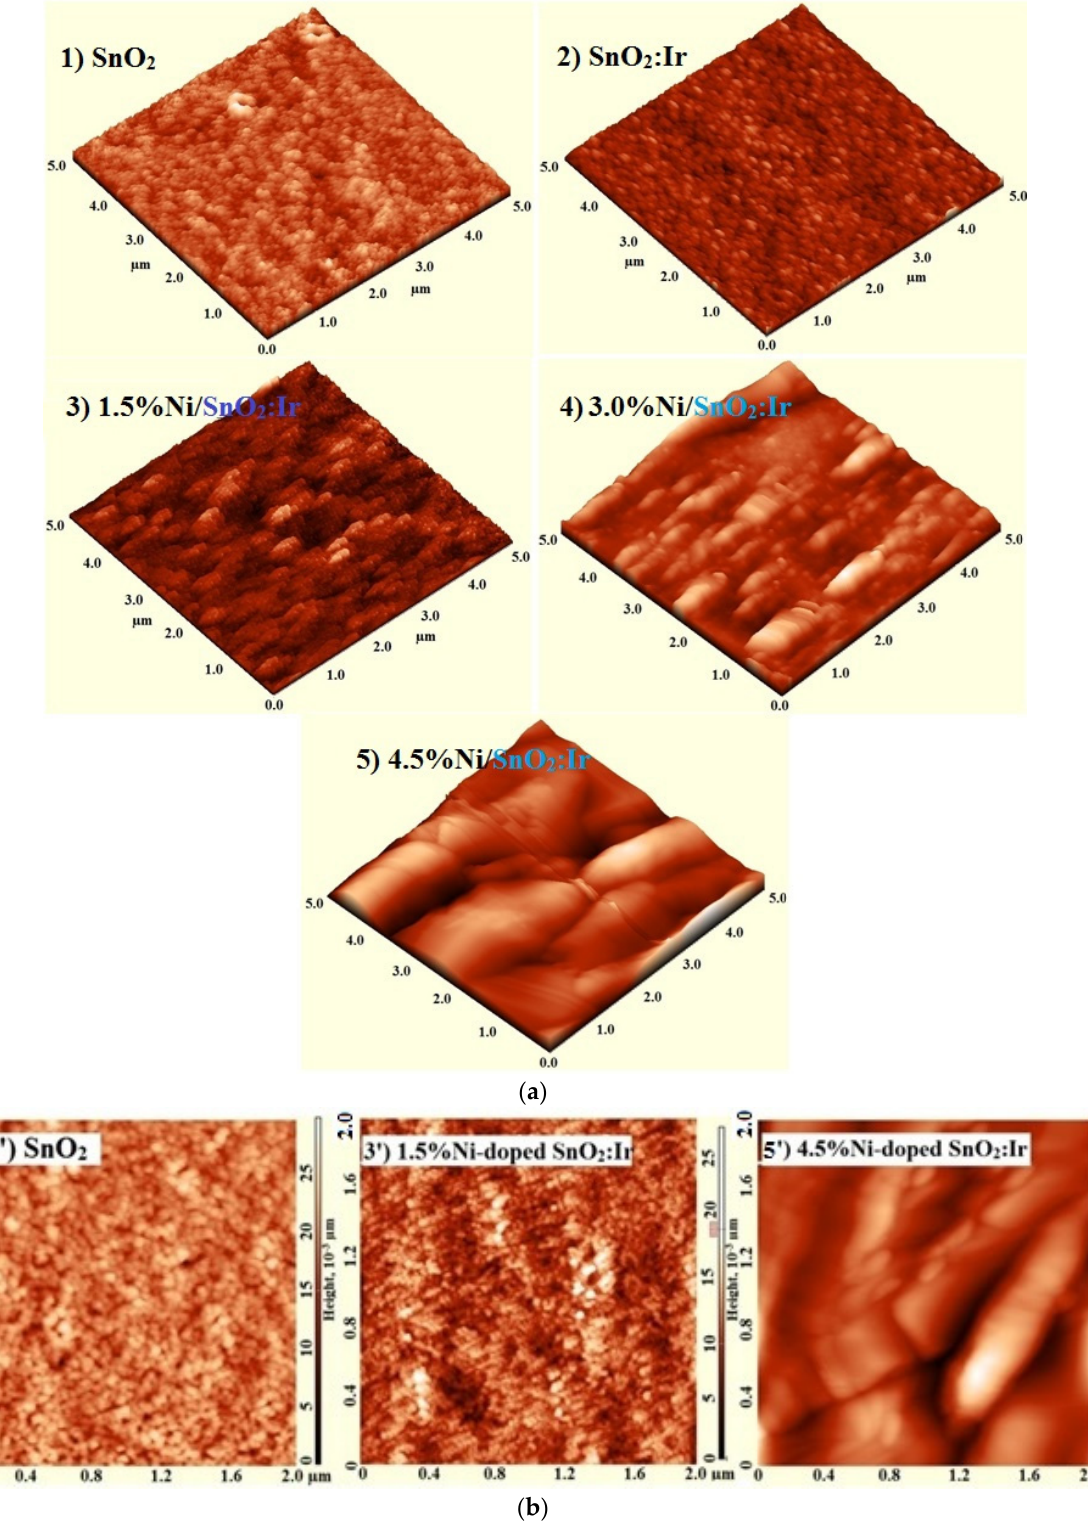
Figure 2. ( a ) Three-dimensional AFM images for the sol spin-coated SnO 2 , IrSnO 2 , and Ni-doped IrSnO 2 films. ( b ) Two-dimensional AFM images for the SnO 2 , 1.5% and 4.5% Ni-doped SnO 2 :Ir films.